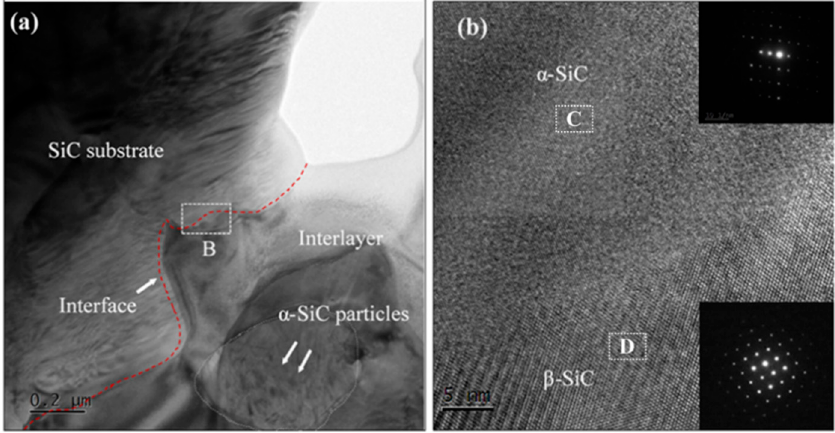
Figure 7. Microstructure and EDS of the joint with different solid loading: ( a ) 13%; ( b ) 19%; ( c ) 26; ( d ) the PDBSE of ( b ); ( e ) the PDBSE of ( c ).